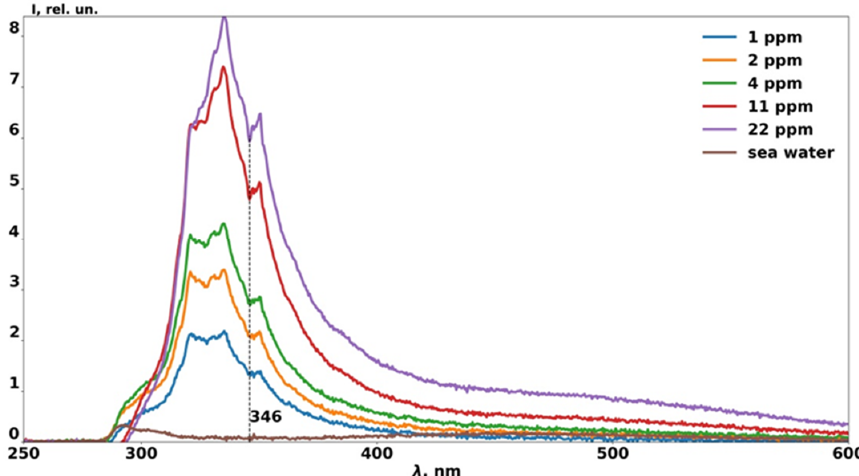
Figure 7. LIF spectra of the RMB 30 solutions.